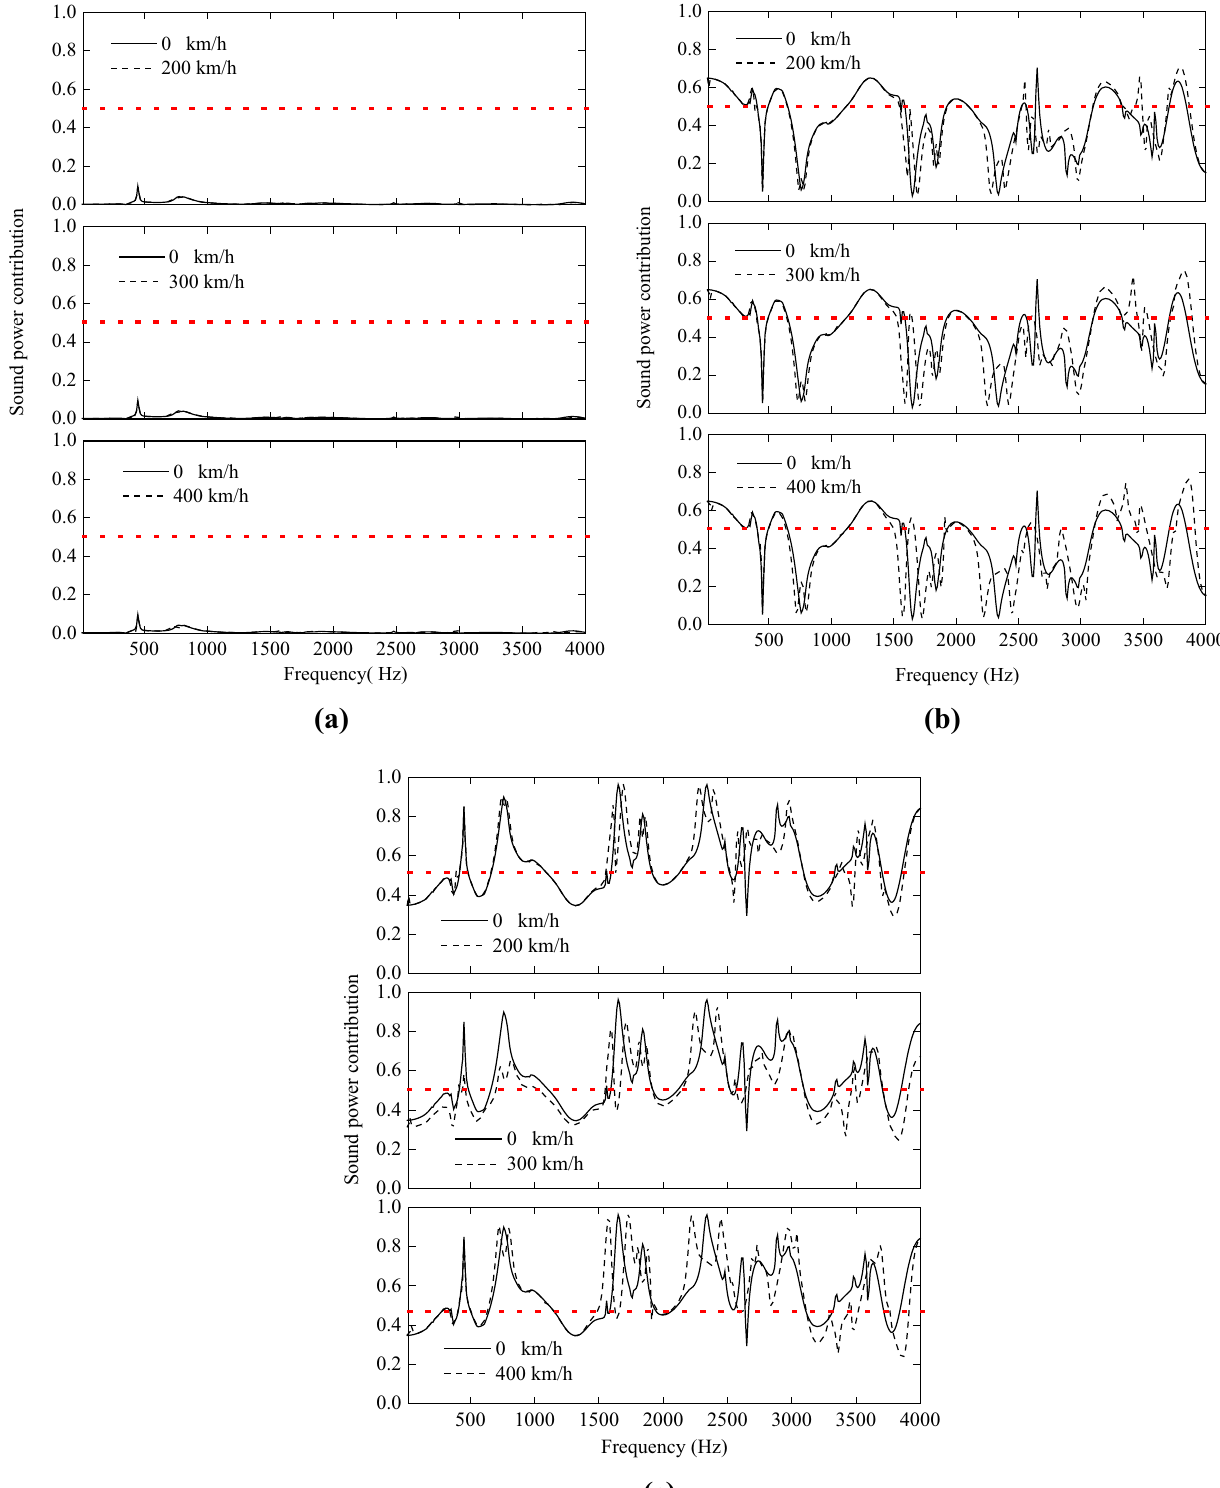
Fig. 13 Influence of the rotation speed on the radiation power contributions of each part of the wheel. a Hub, b web, c